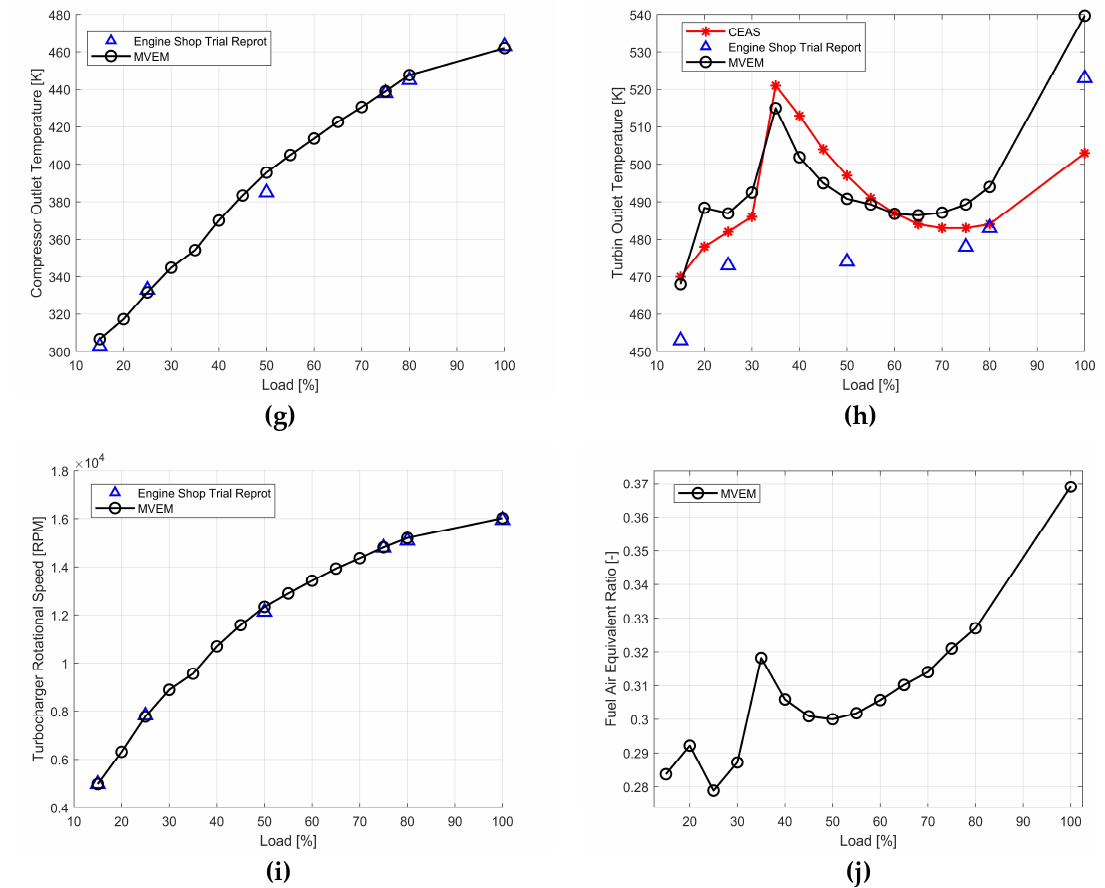
Figure 11. Steady state simulation results and comparison with engine shop trial report and CEAS (Computerized Engine Application System): ( a ) brake power; ( b ) brake specific fuel consumption (BSFC); ( c ) exhaust manifold pressure; ( d ) exhaust manifold temperature; ( e ) scavenging manifold pressure; ( f ) scavenging manifold temperature; ( g ) compressor outlet temperature; ( h ) turbine outlet temperature; ( i ) turbocharger rotational speed; ( j ) fuel-air equivalence ratio.